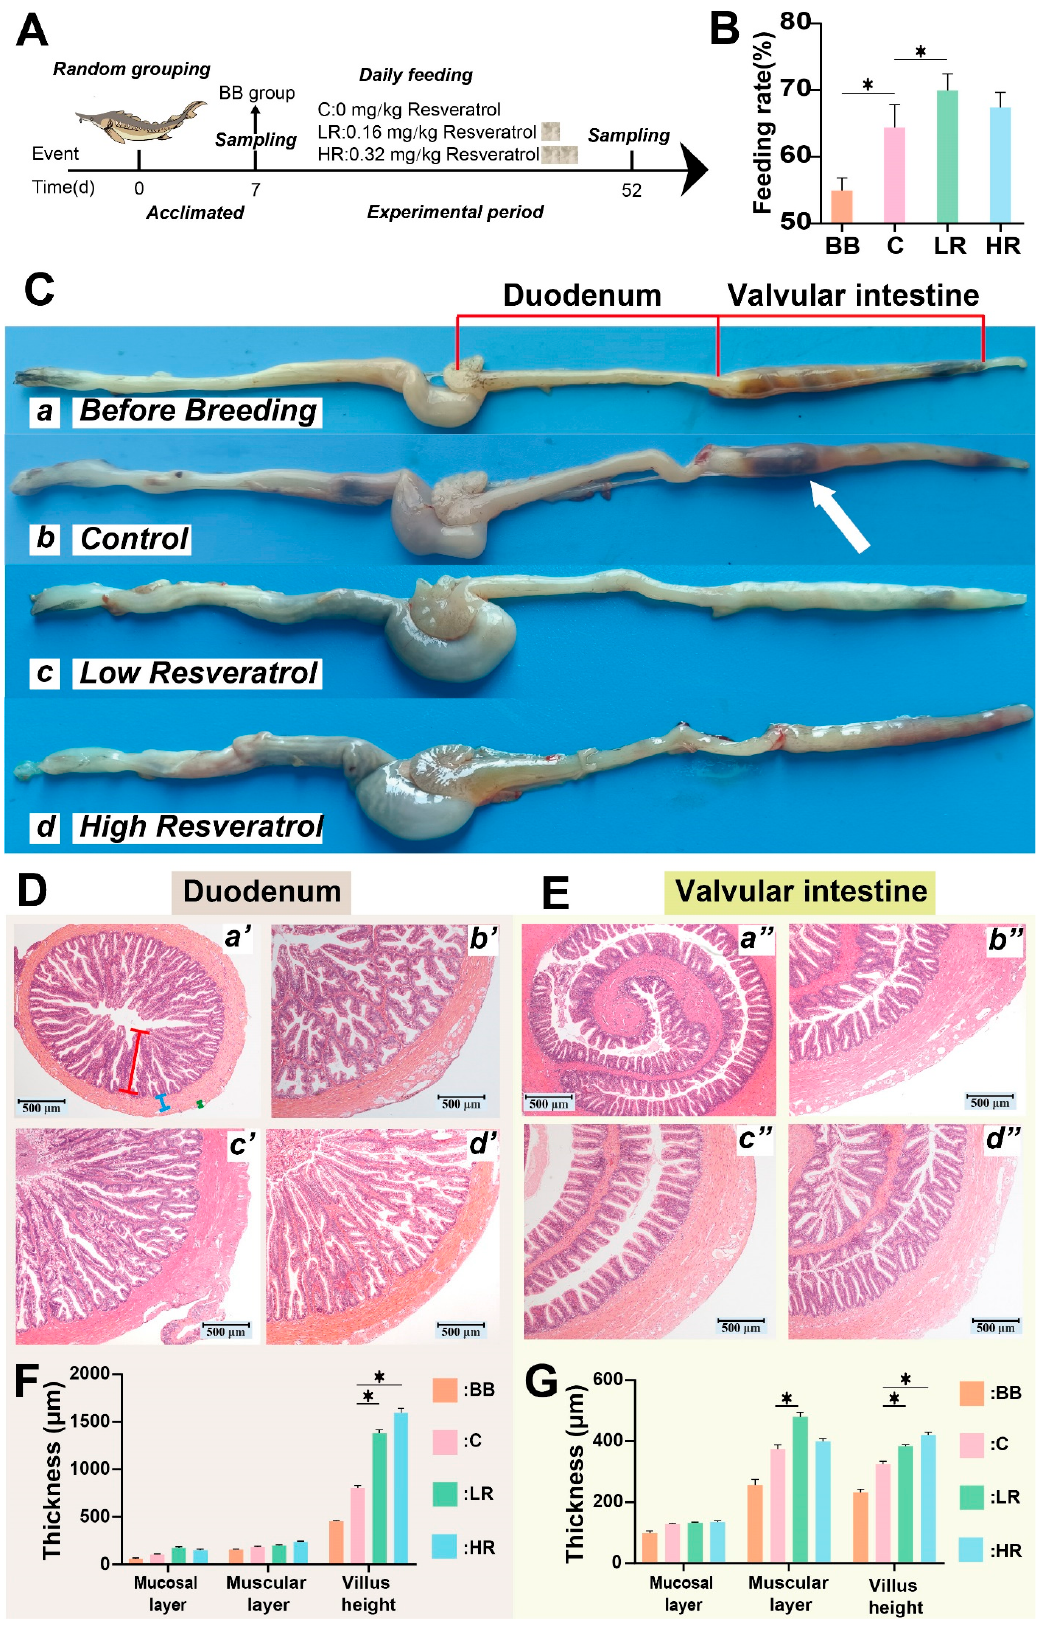
Figure 1. Experimental flowchart, feeding rate, and histological observation of Siberian sturgeon. ( A ) Experimental flowchart, sampling at day 7 indicates before breeding (BB) group, sampling